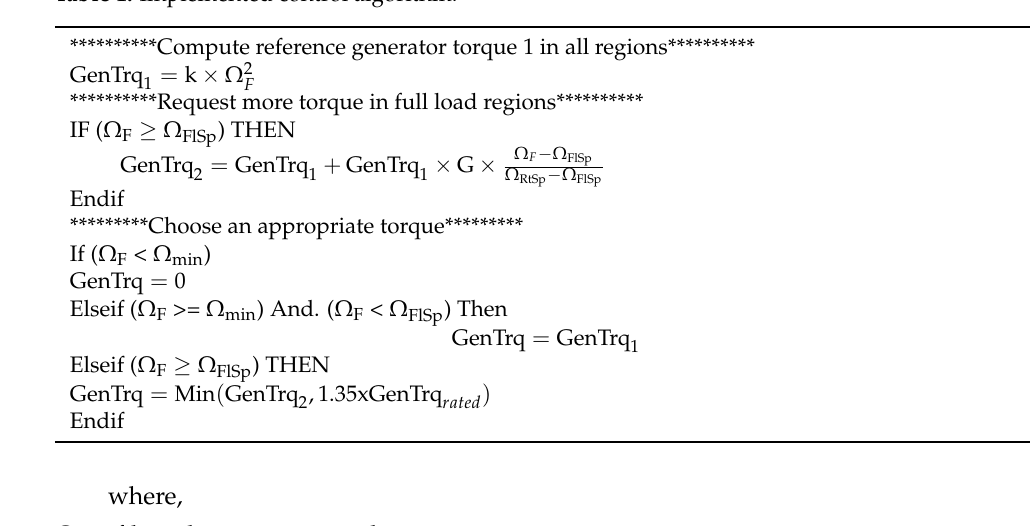
Figure 1. Rotor torque as function of rotor speed at variable wind speed. Table 1. Implemented control